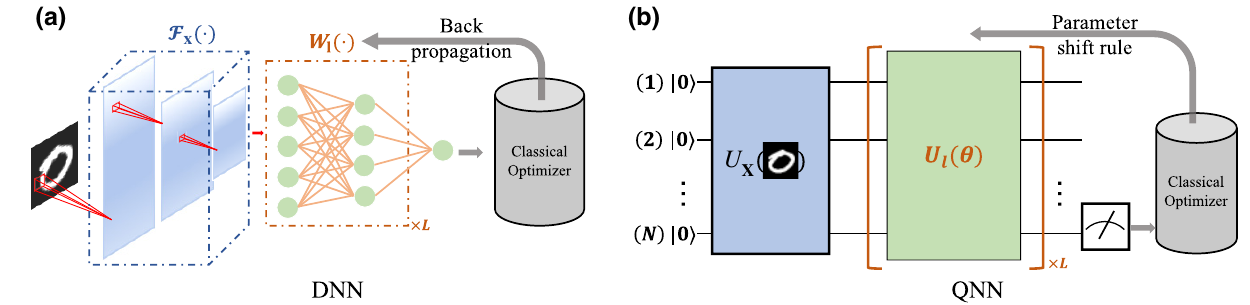
FIG. 1. Illustration of DNN and QNN. The left and right panel shows a DNN and QNN, respectively. For DNN, the feature embed- ding layers F x ( · ) , which contain a sequence of operations with the arbitrary combination such as convolution and attention, maps the input “0” to the feature space. W l ( · ) is the l th fully connected layer. For QNN, an encoding quantum circuit U x maps the classical input “0” to the quantum feature space. U l ( θ ) is the l th trainable quantum circuit layer. Classical information for optimization is extracted by quantum